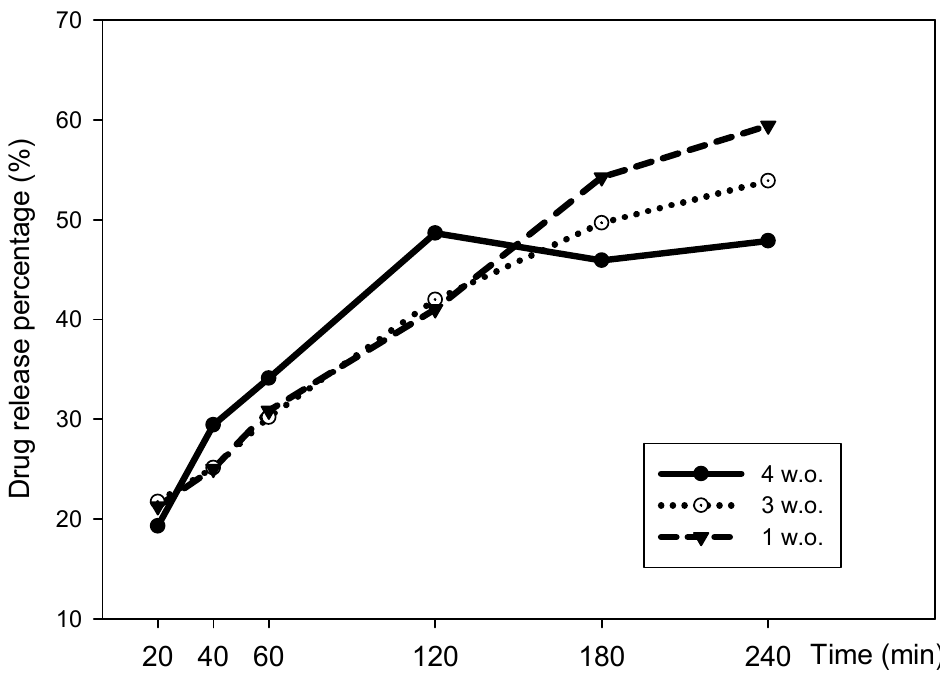
Figure 6. Drug release percentage of NCTD nanoemulsion batches, 1, 3, and 4 w.o. Table 2. Drug release rate and cumulative drug release rate’s multiple linear regression analysis of NCTD nanoemulsion batches.